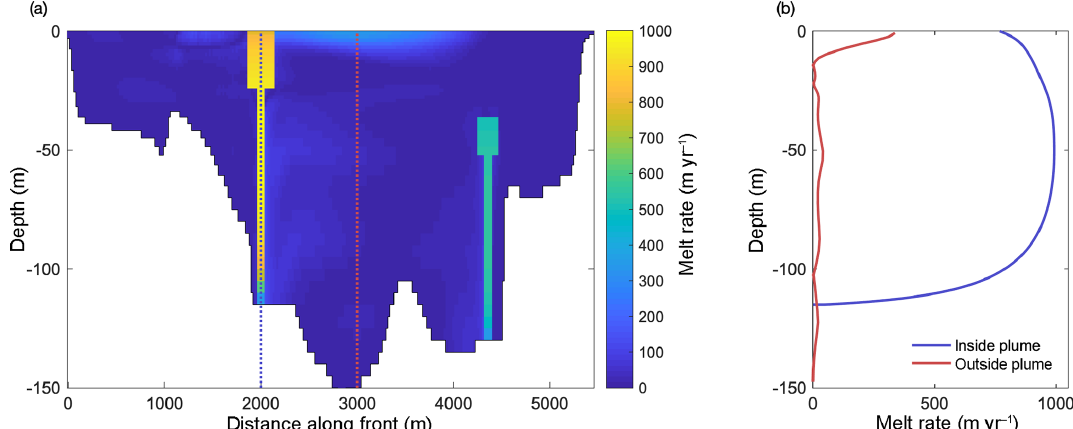
Figure 5. (a) Time-mean melt rates along the glacier front as estimated from MITgcm, adapted from Slater et al. (2018), their Fig. 3f. The bathymetry in the model (white) is based on that of Stevens et al. (2016). (b) Melt rates averaged inside the main discharge plume (blue) and outside of both plumes